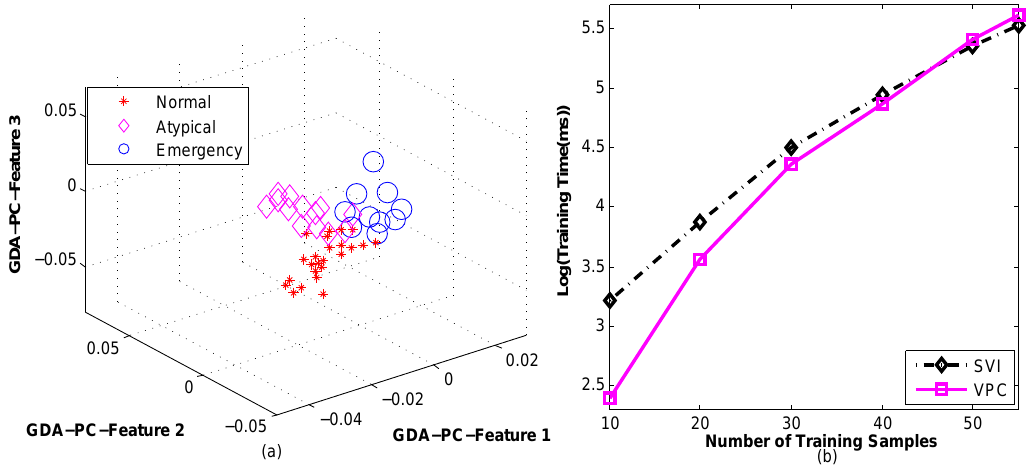
Figure 9. ( a ) Plotting of GDA-PC features of three types of psychiatric state class using HMM as a classifier; and ( b ) comparison of training times between VPC- and SVI-based HMM